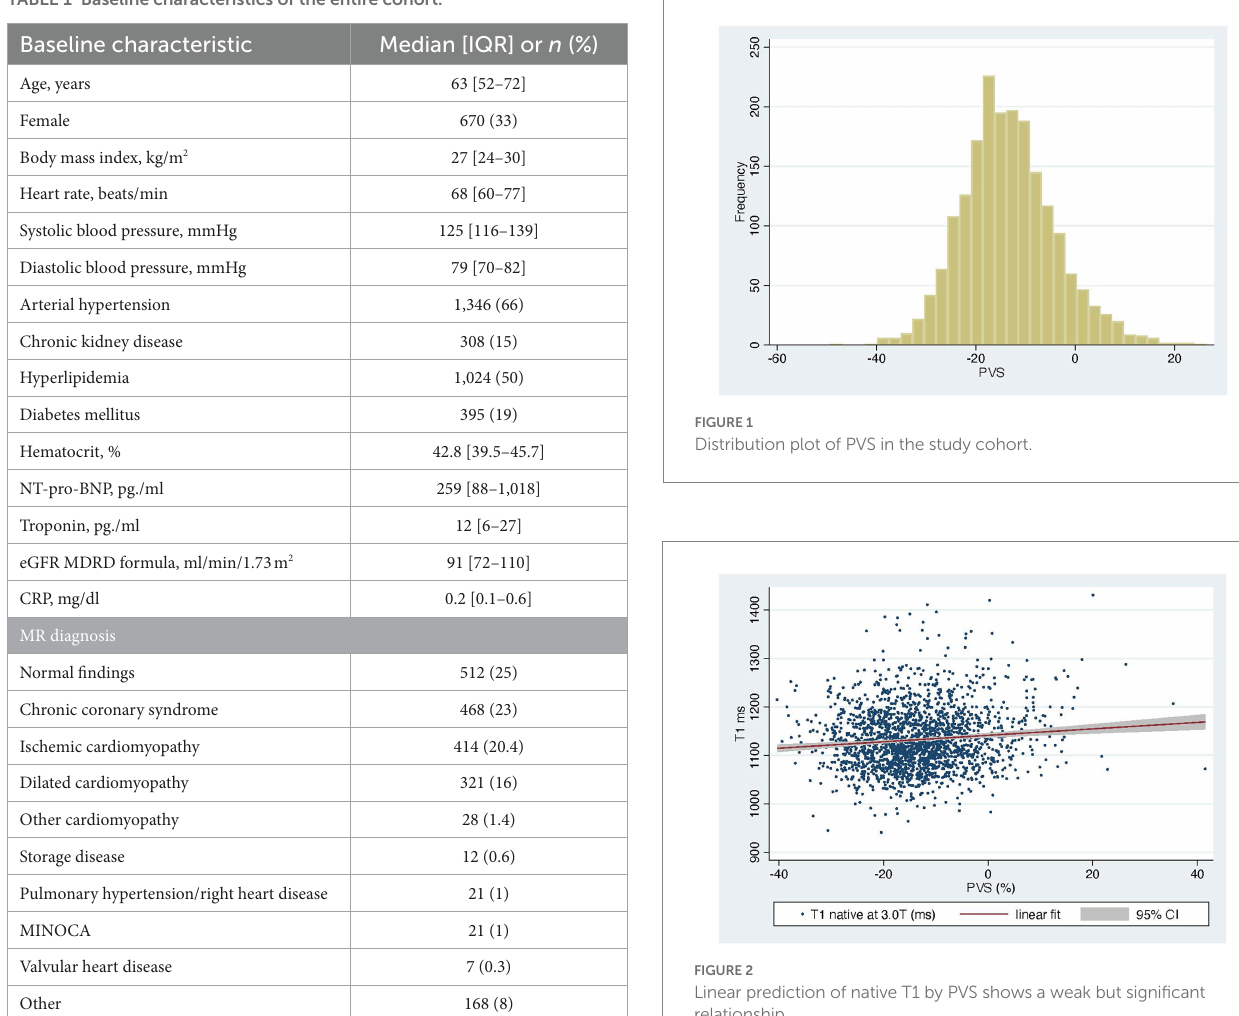
TABLE 1 Baseline characteristics of the entire cohort.